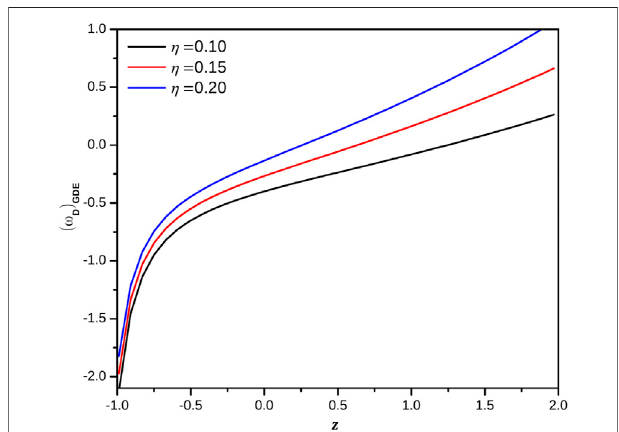
FIGURE5| Plotofequationofstate parameter ofghostdark energy f ( Q ) gravity model versus redshift for the appropriate choice of constants.